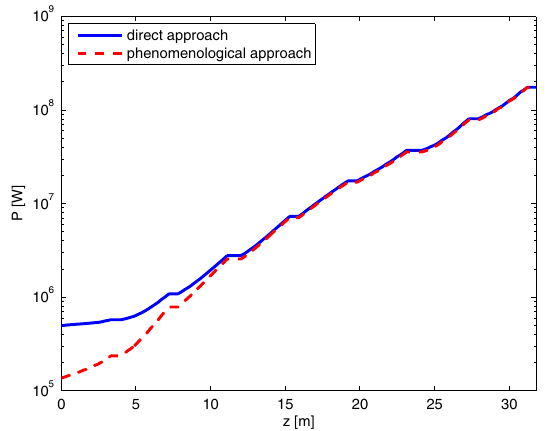
FIG. 17. Spectra of the radiation at seeded undulator entrance (top figure) and exit (bottom figure). The radiation was propa- gated through the seeded undulator with the direct (solid line) and the phenomenological (dashed line) approaches. Photon energy is 1000